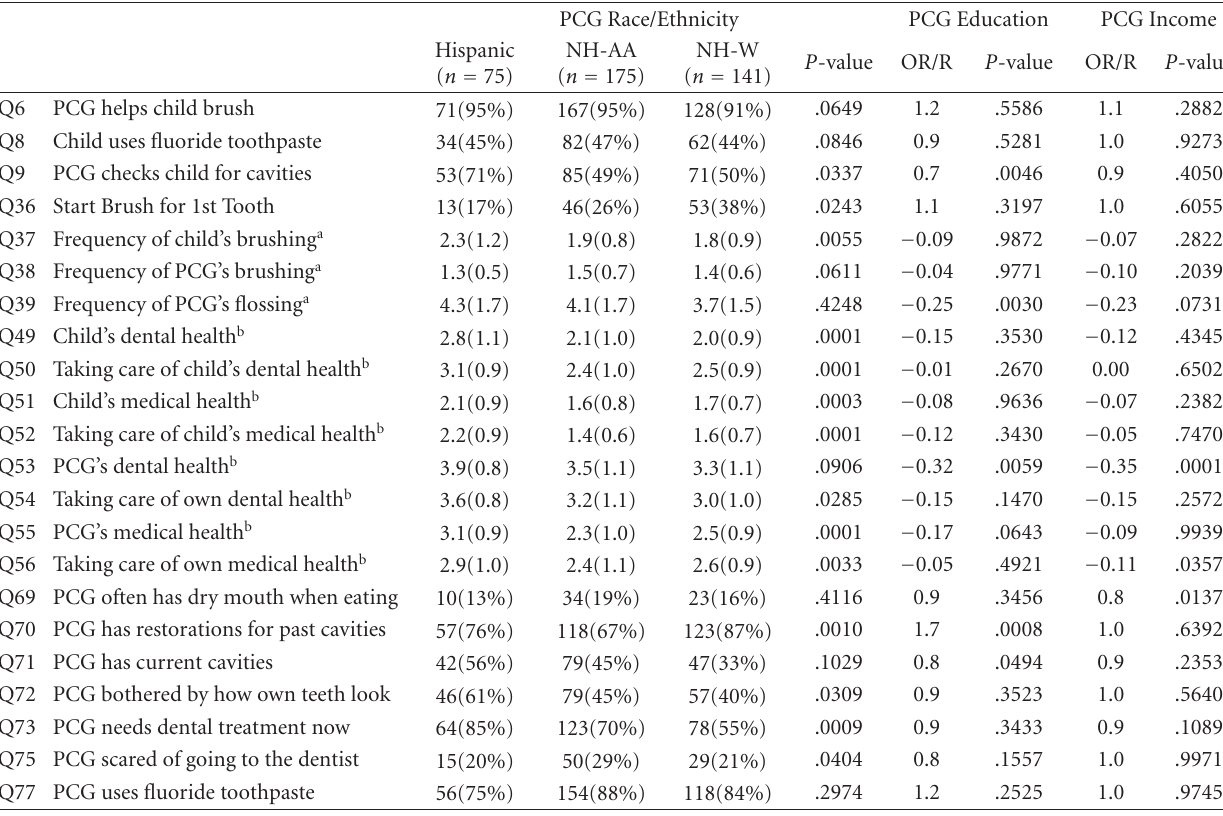
Table 2: Relationships of race/ethnicity, education, and income with questionnaire responses for dental and medical health practices of the primary caregiver (PCG) and the toddler. Analyses were performed for each questionnaire item using multivariable logistic or linear regression models with race/ethnicity, income, and education as predictors. Race/ethnicity P -values are for the overall test of any di ff erence among the three groups. Questionnaire item numbers are listed in the left-most column (see the appendix for questionnaire). N (%) or Mean(SD) for race/ethnicity, odds ratio (OR) or correlation (R) for education and income. NH-AA = Non-Hispanic African-American, NH-W = Non-Hispanic